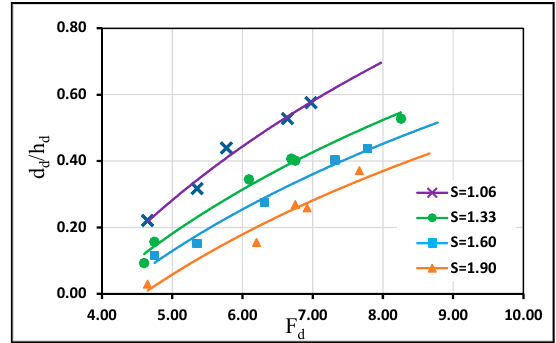
/ h ff erent (S) and Ar = d d ) and (F d ) for di